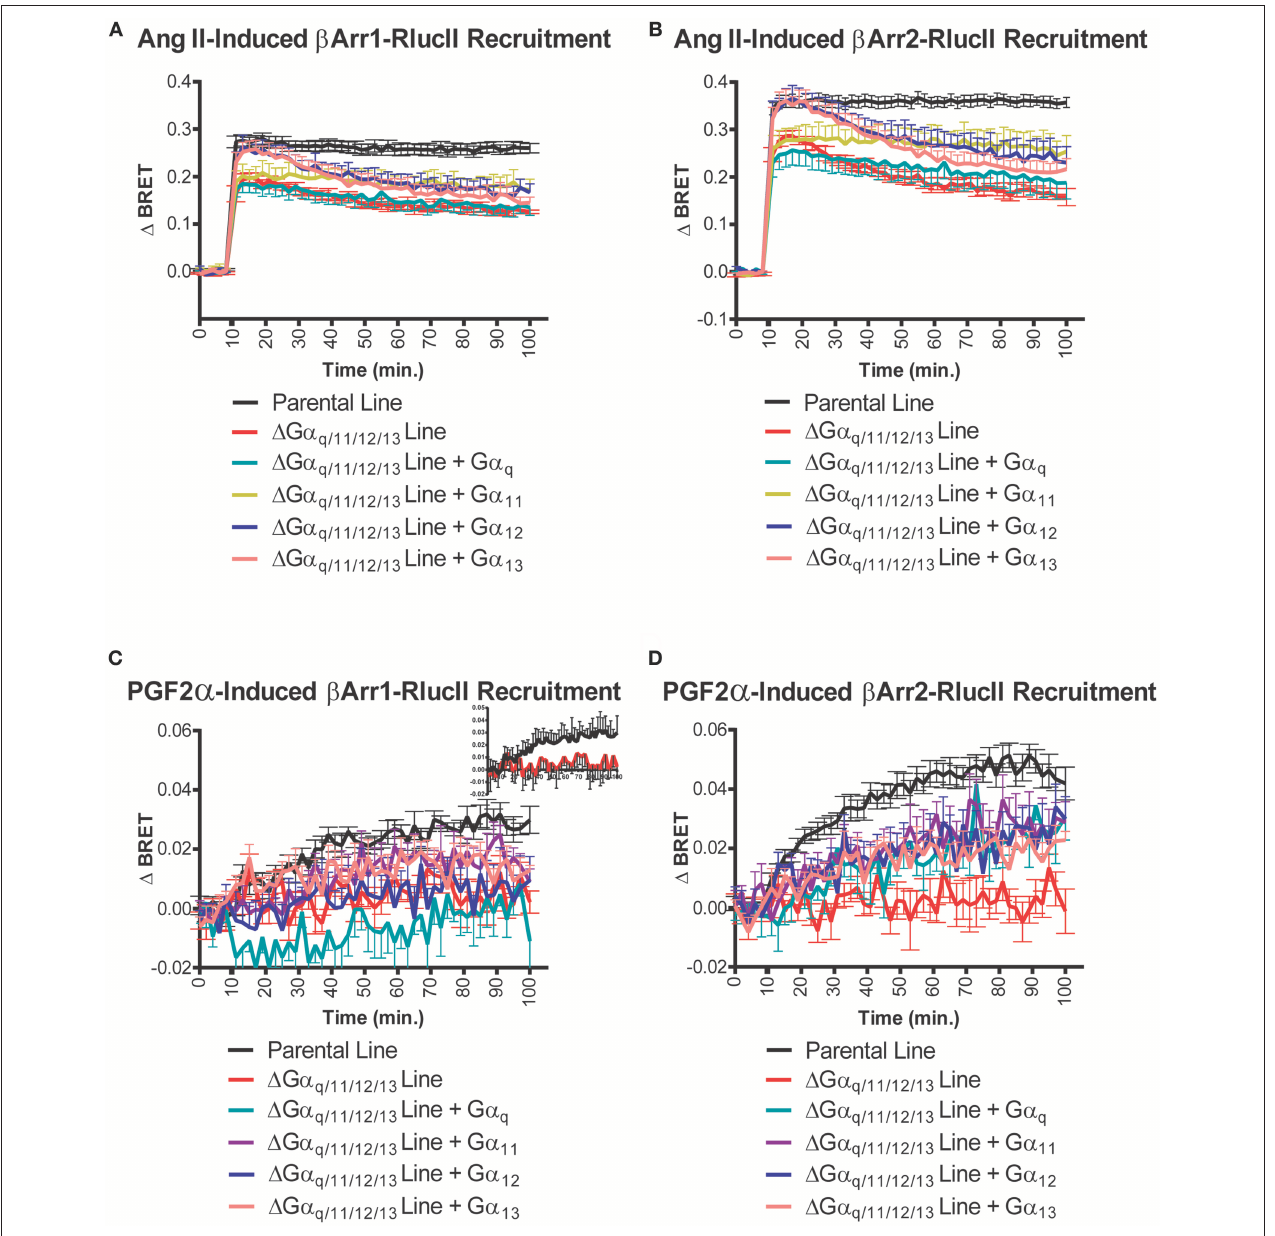
FIGURE 5 | Role of G proteins in Ang II- and PGF2 α -induced β -arrestin 1/2 recruitment to the AT1R/FP dimer. (A,B) Compared to the HEK 293 parental cell line (black lines), Ang II (1 µ M) induced a decaying and much lower, yet sustained recruitment of β -arrestin 1/2-RlucII to the AT1R-Venus/FP-WT dimer when evaluated in the HEK 293 1 G α q / 11 / 12 / 13 cell line (red lines). (C,D) PGF2 α (1 µ M) induced the recruitments of β -arrestin 1/2-RlucII to the AT1R-Venus/FP-WT dimer in the HEK 293 parental cell line (black lines) only, and virtually no responses were detected with the HEK 293 1 G α q / 11 / 12 / 13 cell line (red lines) (C) , inset: The response in parental and 1 G α q / 11 / 12 / 13 cell lines are shown alone for clarity. Data represent mean ± s.e.m. of [biological replicates performed in triplicate ( n =